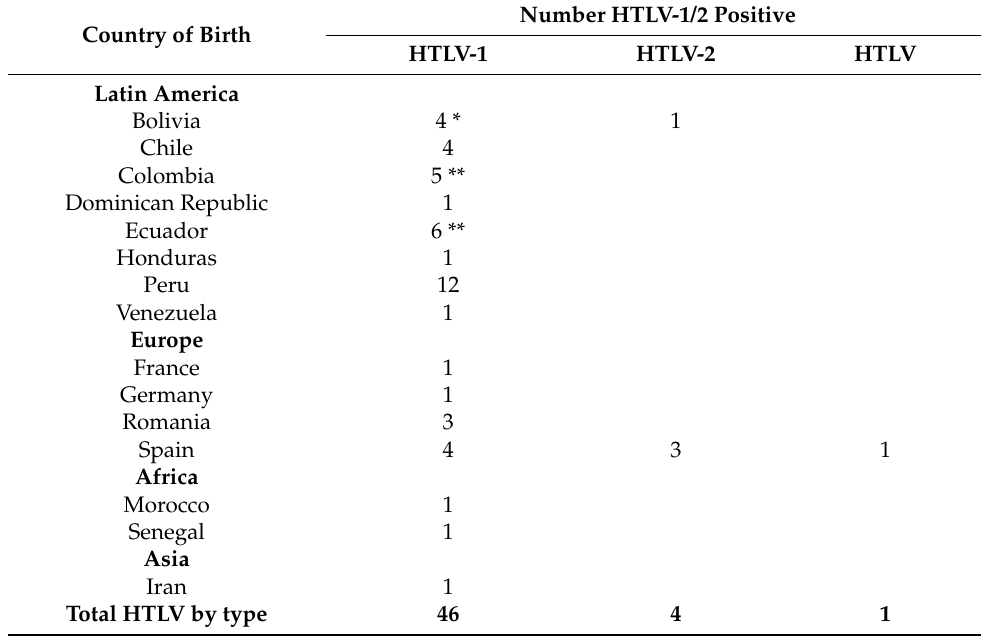
Table 3. HTLV-1/2 positive blood donors according to their birth country (2008–2017). Country of Birth